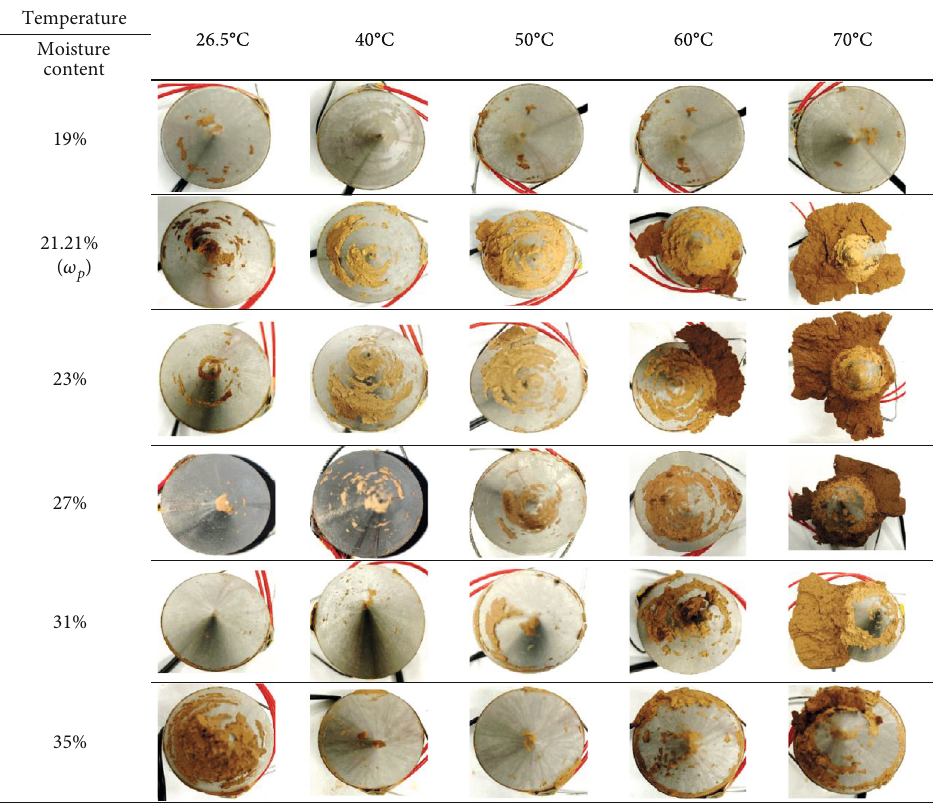
Figure 7: The conditions of soil adhering to